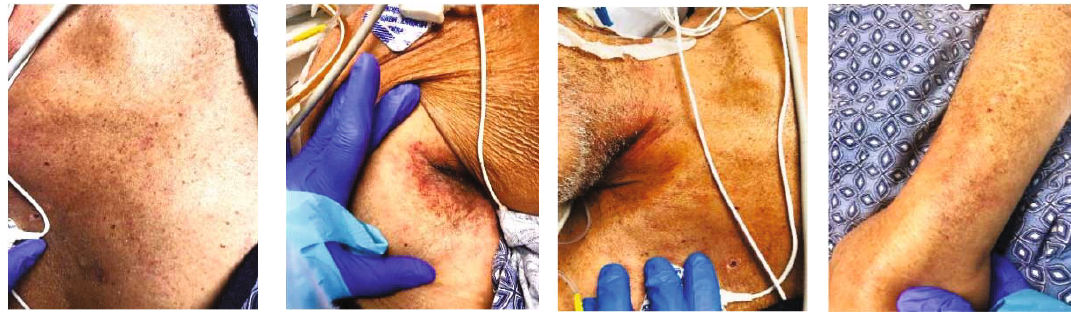
Figure 2: Petechial rash on trunk, axilla, neck, and